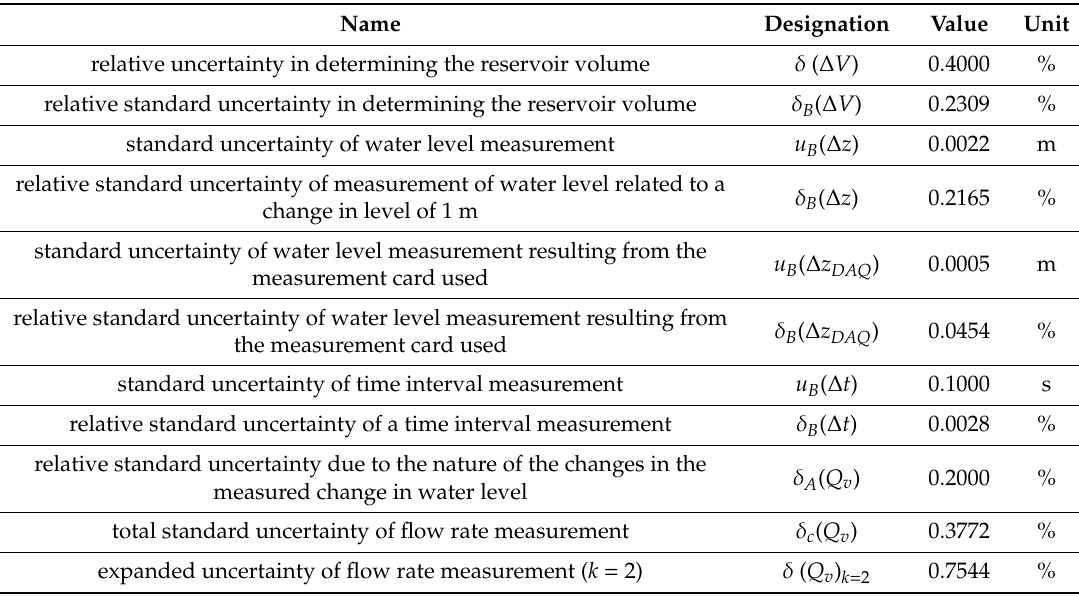
Table A1. The results of calculations of uncertainty of the flow rate measurement results obtained using the volumetric gauging method.